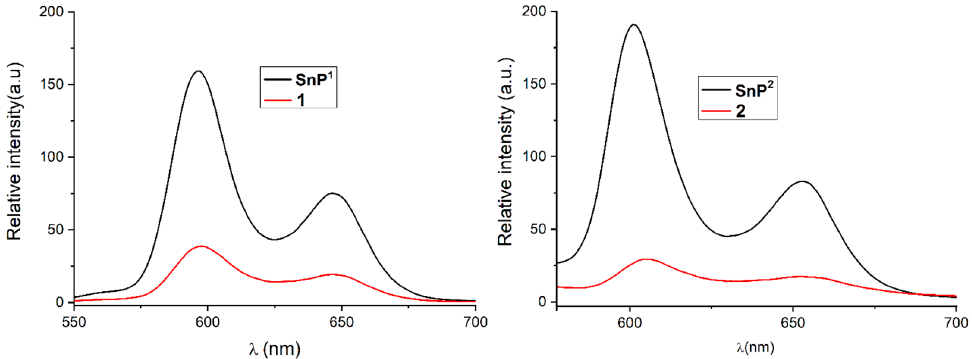
Figure 2. The fluorescence spectra of SnP 1 , SnP 2 , 1 , and 2 in chloroform.